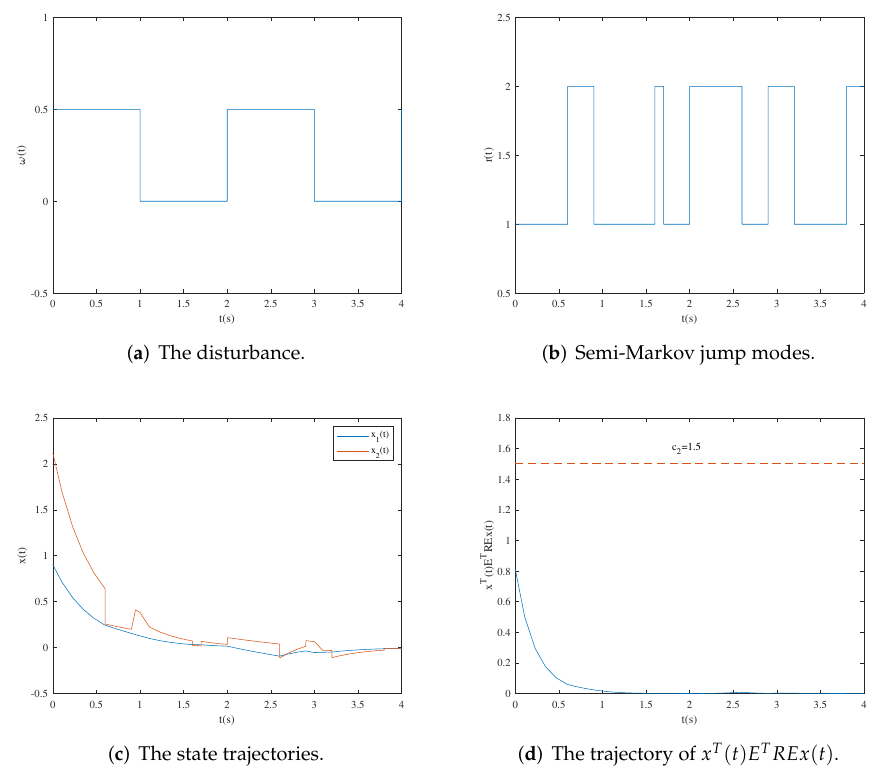
Figure 2. The closed-loop